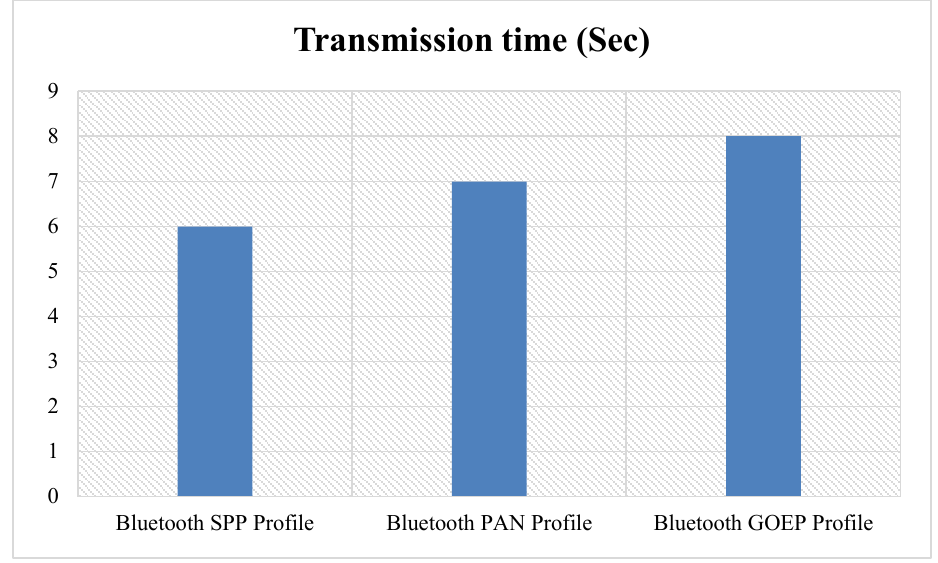
Figure 9. Transmission Time results of the Bluetooth SPP, Bluetooth PAN and the Bluetooth GOEP